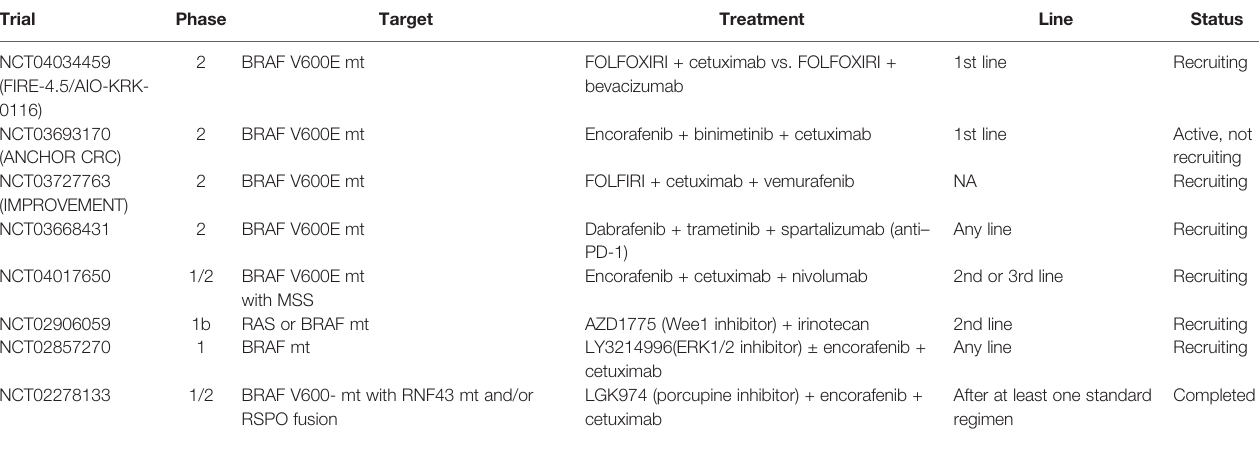
TABLE 3 | Ongoing trials for BRAF -mutated